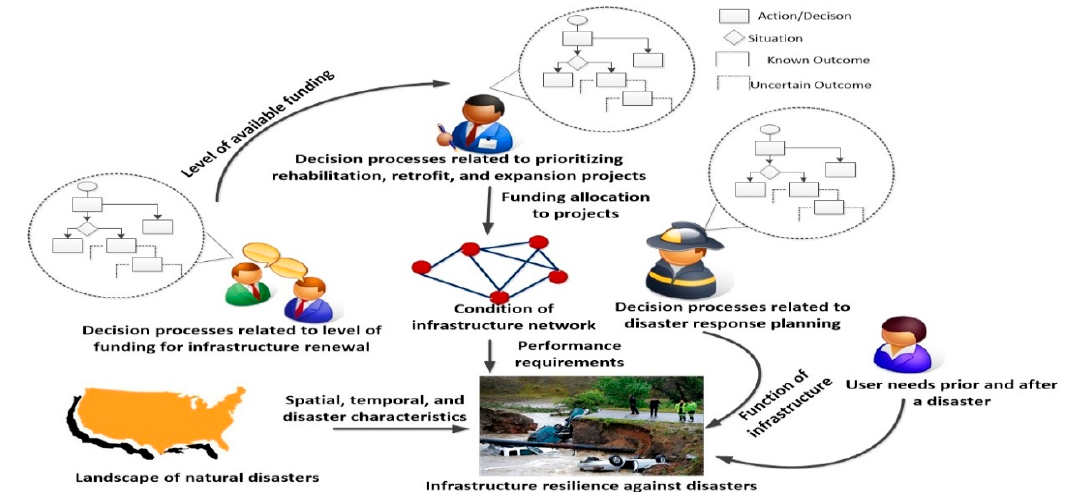
Figure 1. Infrastructure resilience: a system-of-systems problem.